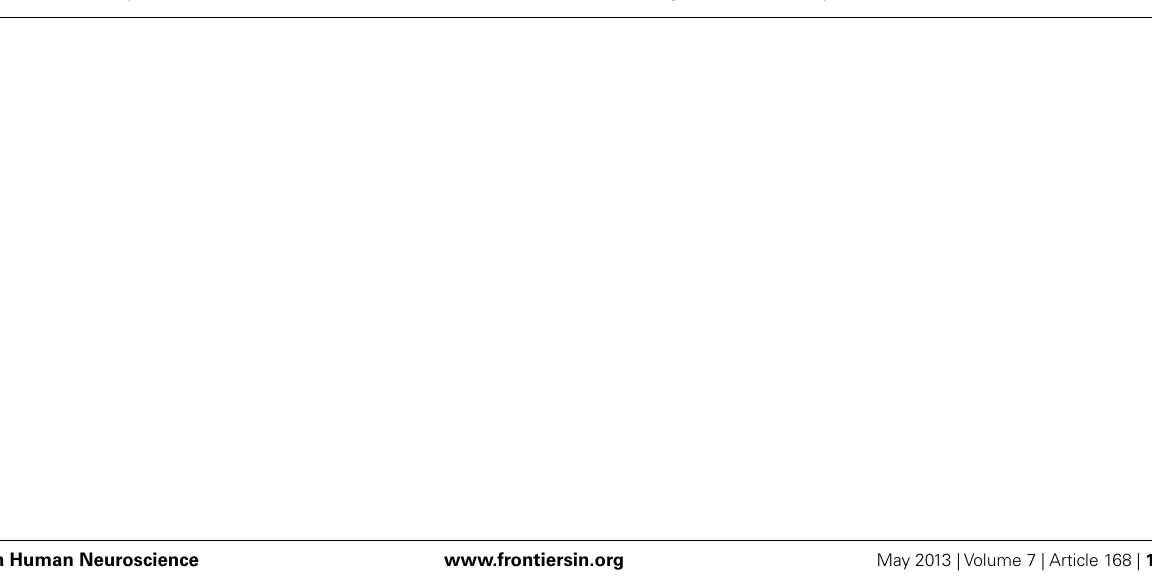
FIGUREA1 | Concatenated time-series (left) and corresponding spectra (right) of two example components. Top: a component dominated by a single subject – most of the variance of the time course originates from subject 2 (time points 1001–2000 in the concatenated time-series). Bottom: a component that is equally present in all subjects, i.e., the variance in the concatenated time course is more homogeneous across